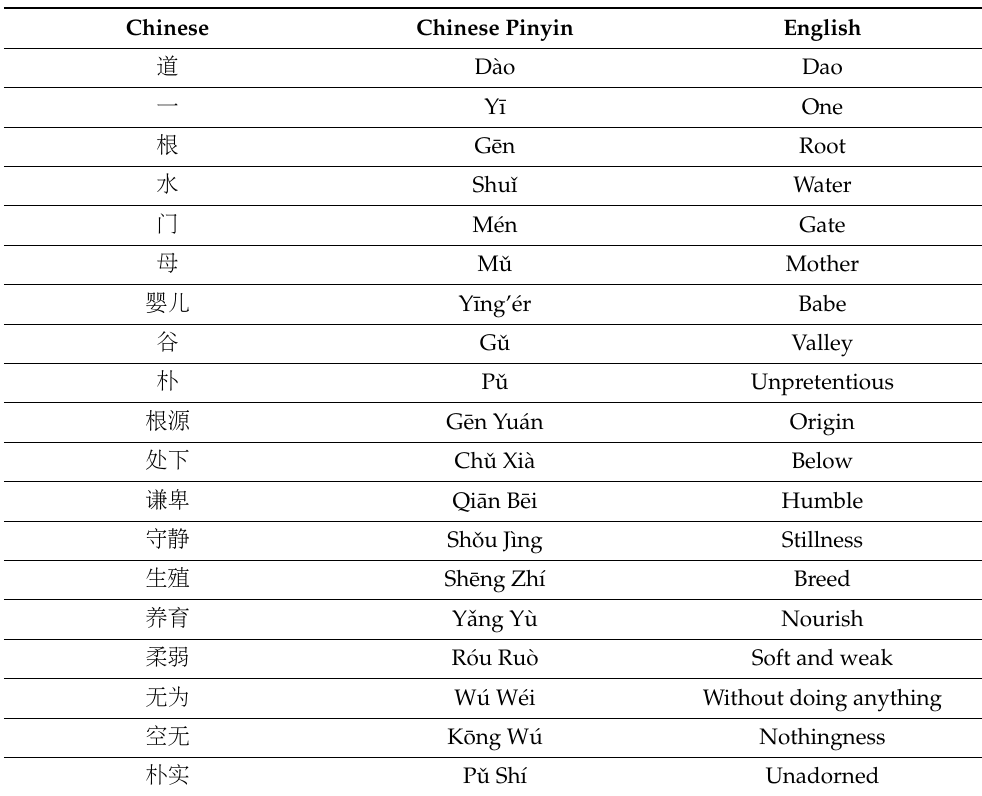
Table 1. Terms in Figure